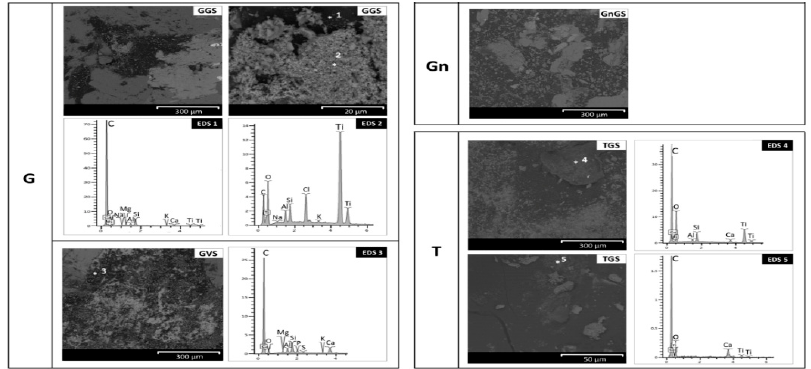
Figure 10. SEM micrographs and EDX spectra of the stones coated with the sacrificial anti-graffiti product after being cleaned with the product recommended by the manufacturer. Check Table 1 for sample labeling.